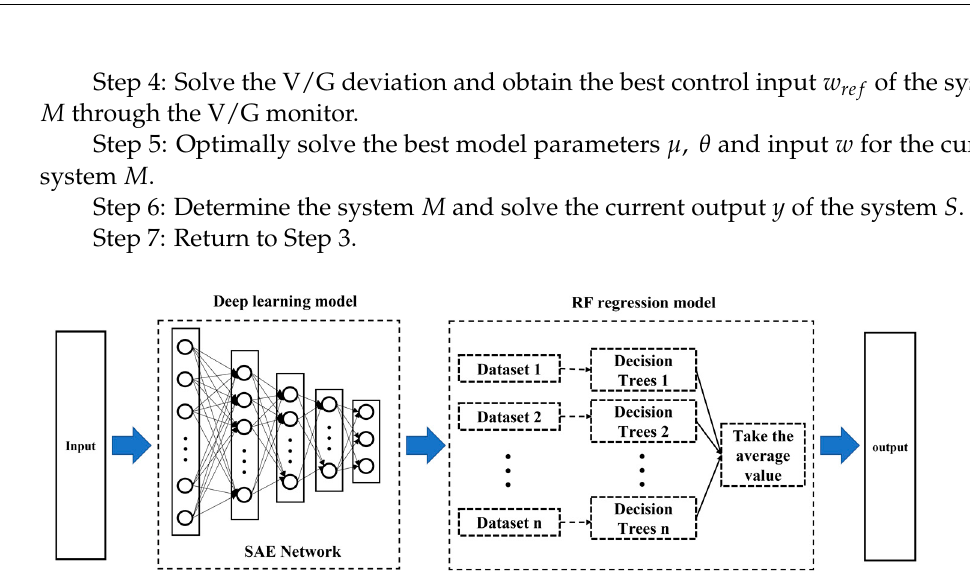
Figure 4. SAE-RF-based soft sensor model.